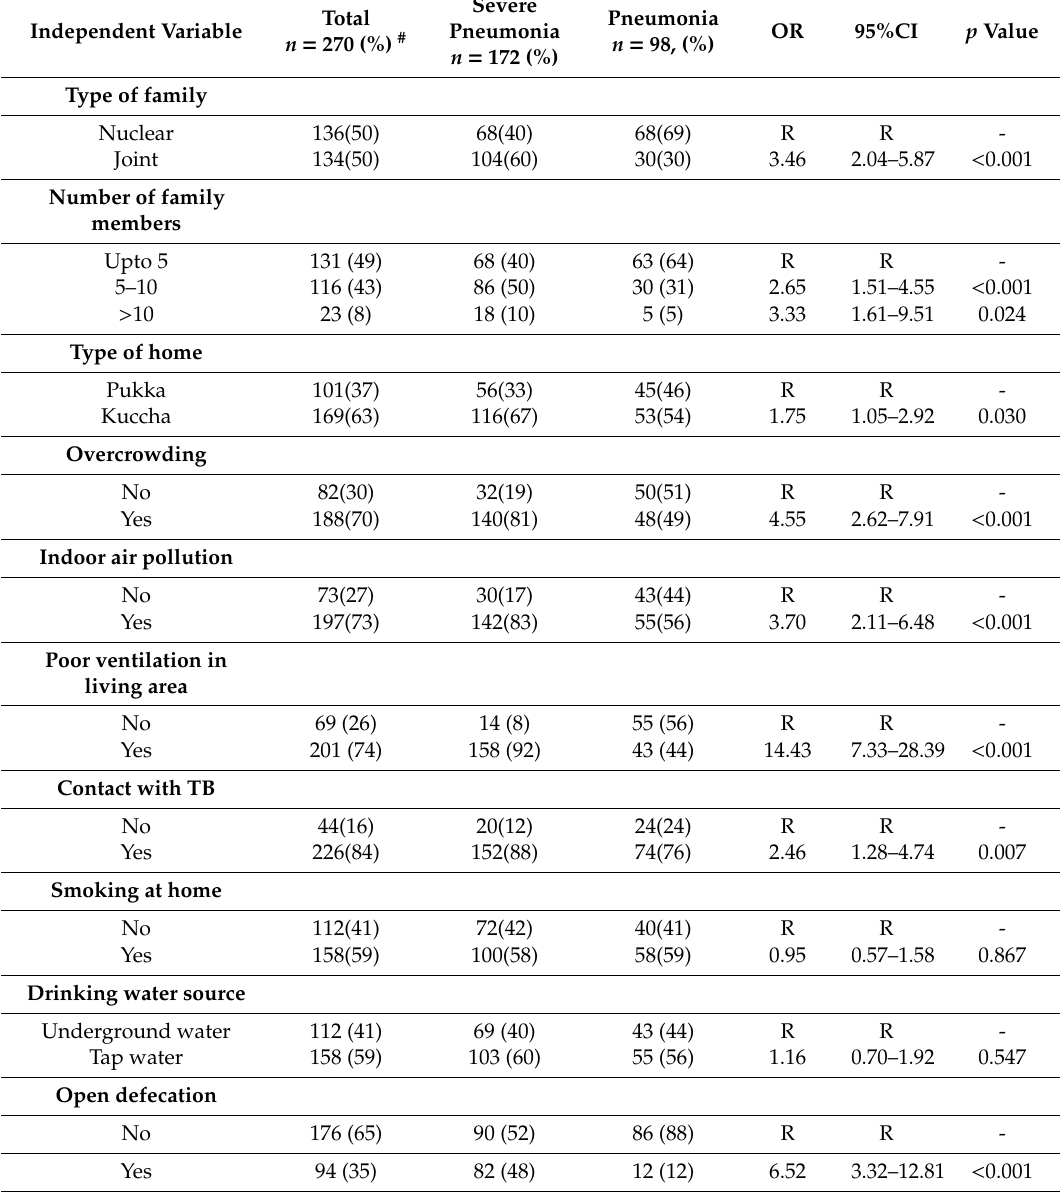
OR—odds ratios, CI—Confidence interval, # —Column percentage, R—referent